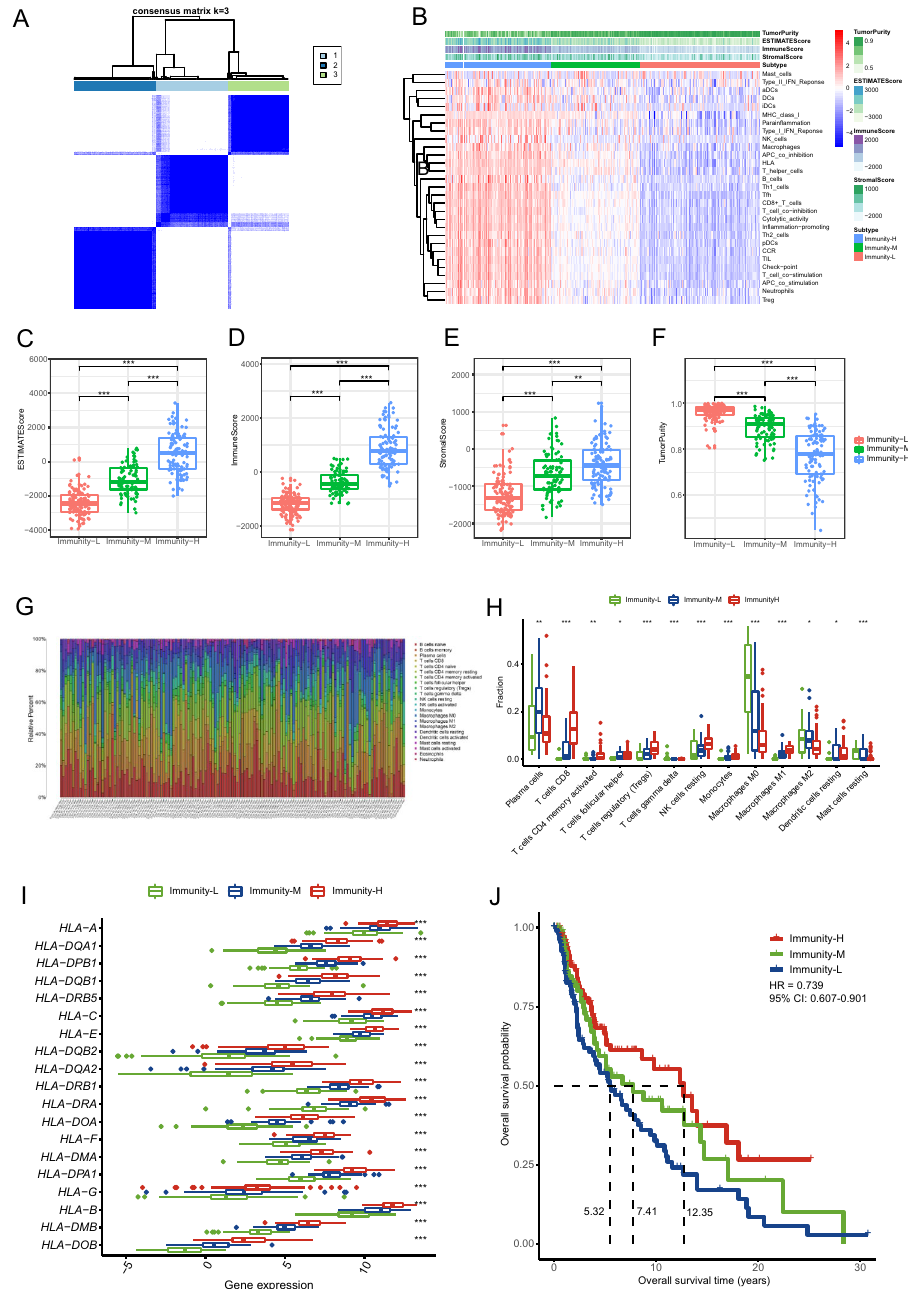
Figure 2. Three immune level groups were determined by ssGSEA and consensus clustering analysis. Cluster process diagram of consensus clustering analysis ( A) . Heatmap of the ssGSEA score for all CM patients in the training set ( B) . ESTIMATE score ( C) , immune score ( D) , stromal score ( E), and tumor purity ( F) of the different immune groups. The bar graph shows the proportion of 22 kinds of immune cells in CM tumor samples in the training set. Each column indicates one sample ( G) . The box plot shows the differentiation of 13 kinds of immune cell fraction within the different immune groups ( H) . The box plot displays the difference in HLA gene expression within the different immune groups ( I) . Kaplan–Meier curves of the three different immune groups and the result of univariate Cox analysis. HR, hazard ratio. 95% CI, 95% confidence interval ( J) . *p < 0.05, **p < 0.01, ***p <